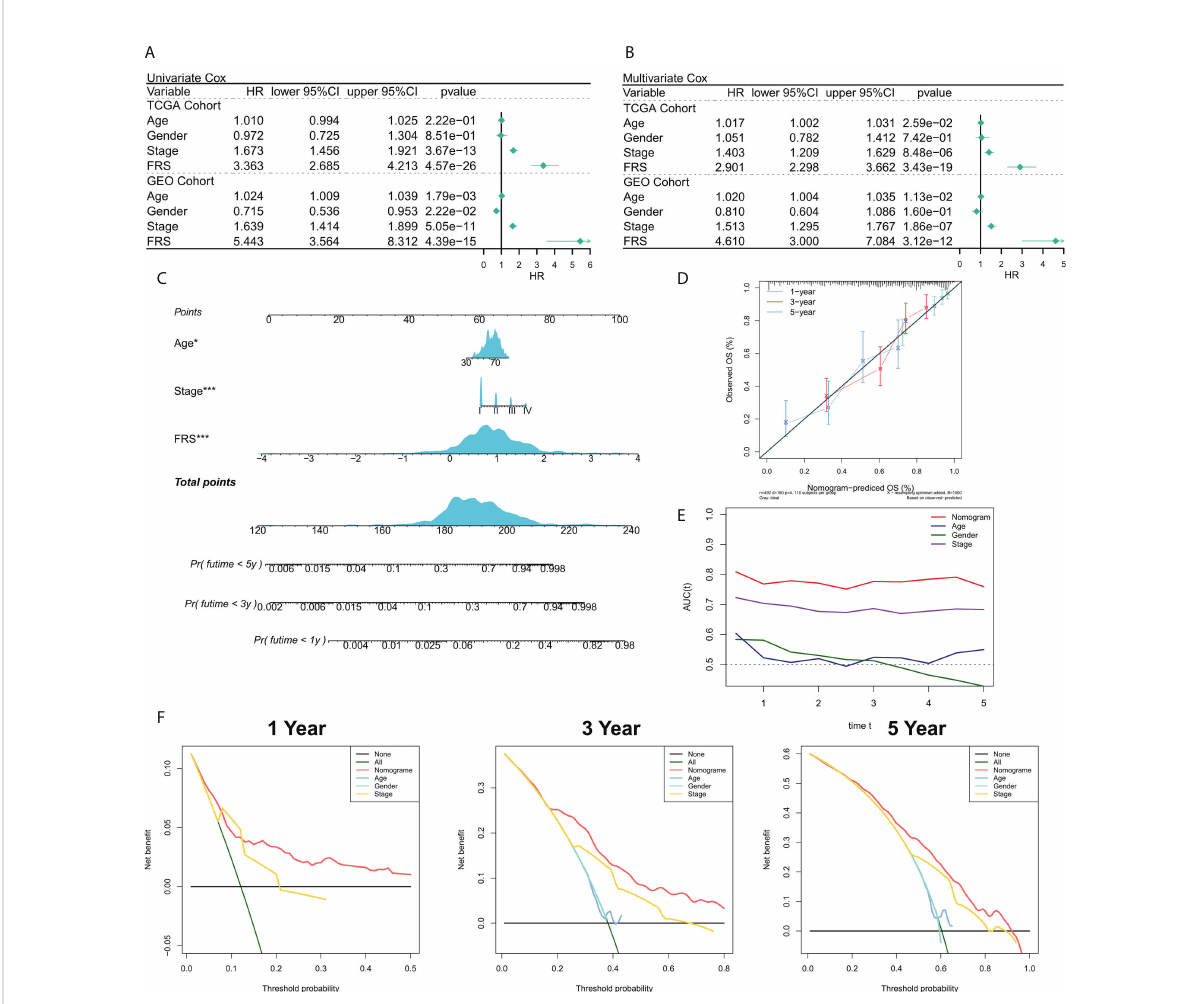
FIGURE 4 Validation of the FRG-related risk model. (A) Univariate Cox regression analysis of OS in TCGA and GEO cohorts; (B) Multivariate Cox regression analysis of OS in TCGA and GEO cohorts. (C) FRS-based nomogram; (D) Calibration curves for the nomogram; (E) tROC curves for the nomogram and clinical characteristics; (F) 1-, 3-, and 5-year DCA curves for the